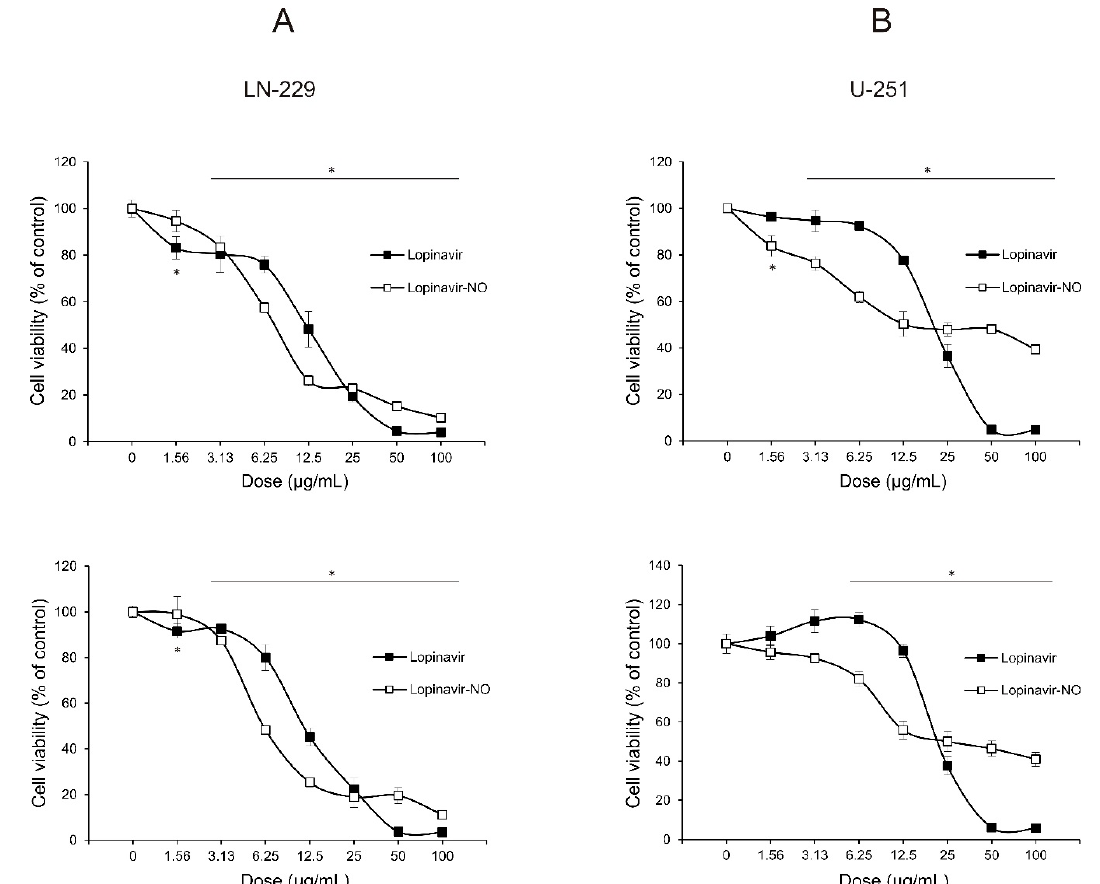
Figure 1. Lopinavir (Lopi) and Lopi-NO reduced the viability of glioblastoma (GBM) cell lines in a dose-dependent manner. LN-229 ( A ) and U-251 ( B ) cells were treated with a range of doses of Lopi and Lopi-NO for 48 h. Cell viability was determined by 3-(4,5-dimethylthiazol-2-yl)-2,5-diphenyltetrazolium bromide (MTT) (upper panel) and crystal violet (CV) assays (lower panel). The data are presented as percentage of control ± standard deviation (SD) from one representative out of three independent experiments. * p < 0.05 refers to untreated